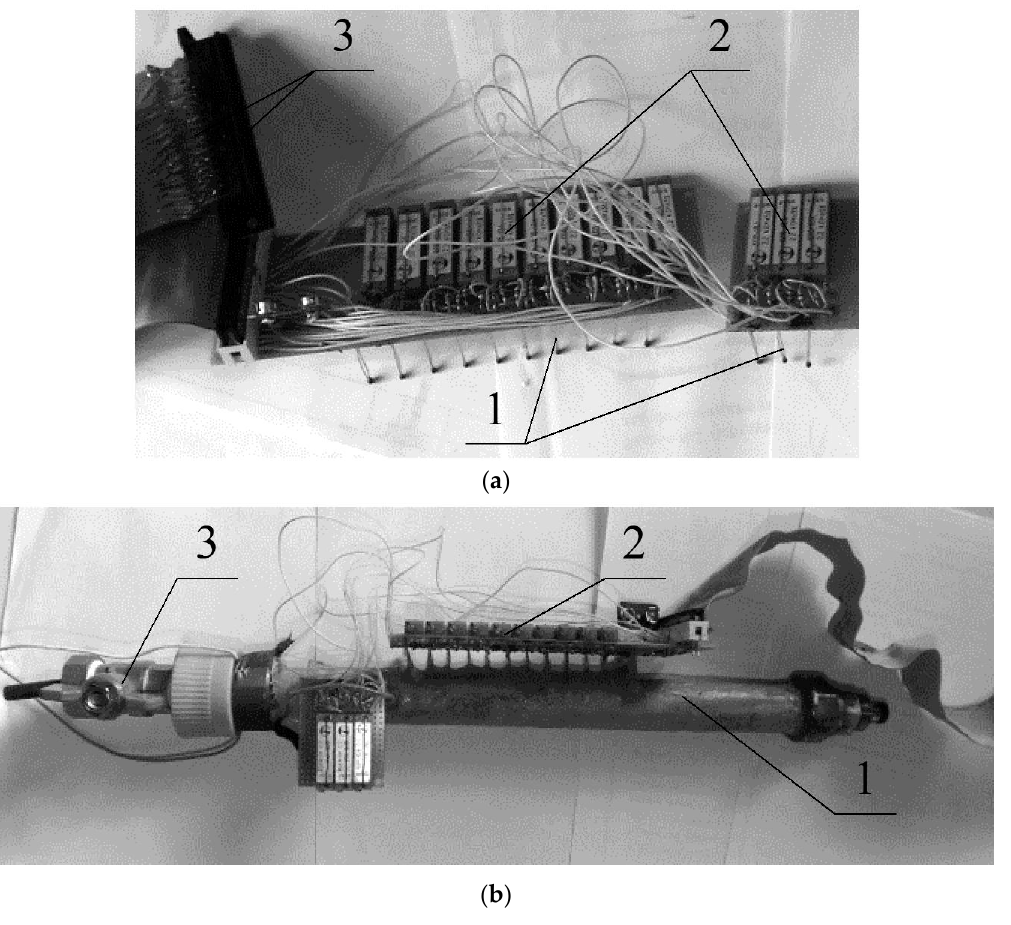
Figure 3. Thermal flowmeter: ( а ) board with measuring bridges (1, thermal converters; 2, balancing resistors of measuring bridges; 3, connector), ( b ) flowmeter prototype а (1, flowmeter tube; 2, board with balancing resistors and thermal converters; 3, fuel tap through the flowmeter).